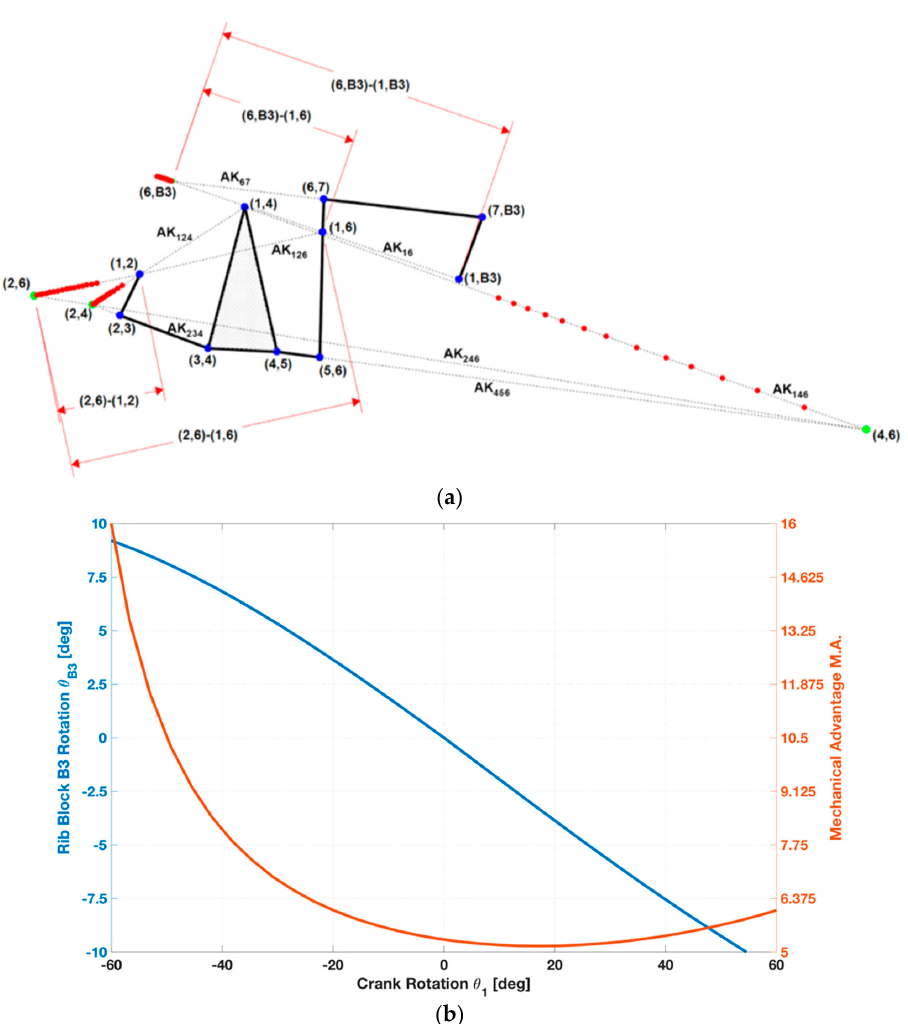
Figure 11. Inner mechanism instant centres analysis: ( a ) Evolution of ICs positions for several IM configurations; ( b ) Mechanical Advantage and output angle curve as function of crank rotation angle.